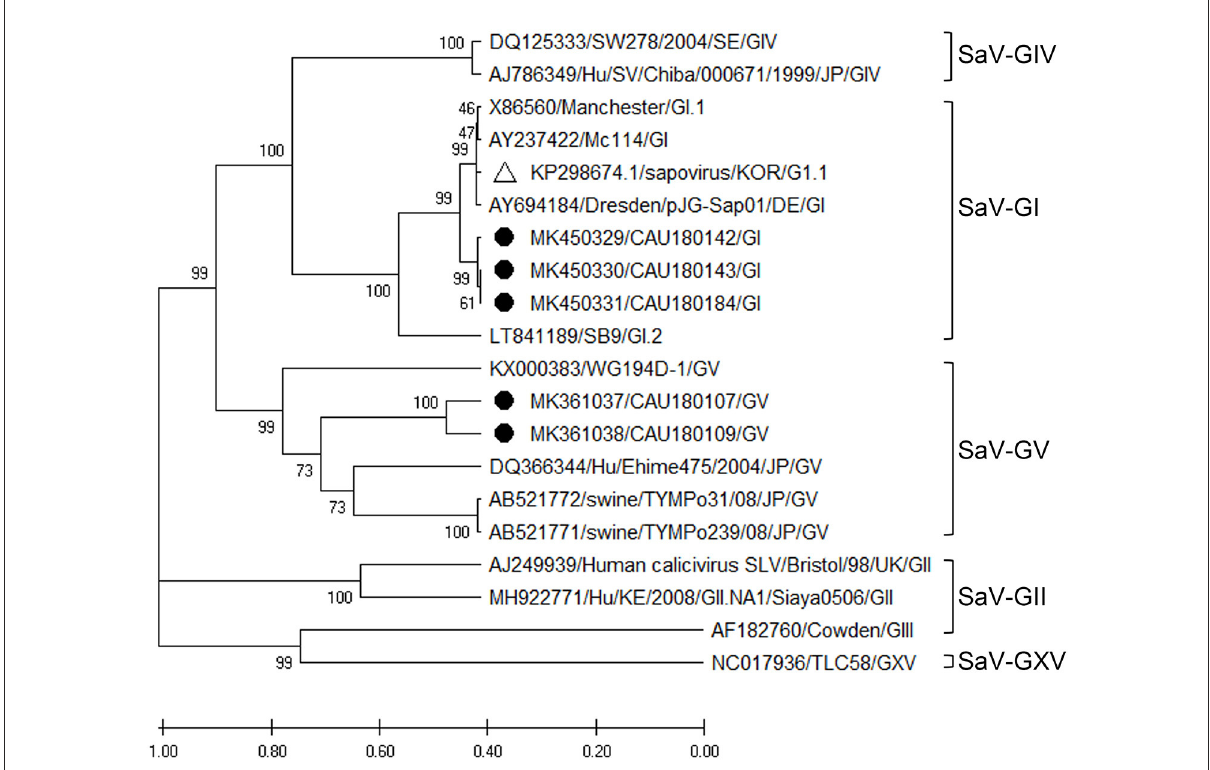
FIGURE5 Phylogenetic analysis of SaV detected in porcine stools and swabs. The SaV phylogenetic tree was constructed following the UPGMA method and based on 416-bp sequences of the VP1 region. Sequences detected in this study are represented as black circles (•). The white triangle ( 1 ) represents the human SaV strain (KP298674/KOR/G1.1) that was confirmed in the Republic of Korea. The phylogenetic analysis included SaV-GI (four strains), SaV-GII (two strains), SaV-GIII (one strain), SaV-GIV (two strains), SaV-GV (four strains), and SaV-GXV (one strain) as reference sequences. The numbers at the nodes of the tree indicate bootstrap values and the scale bar indicates nucleotide substitutions per